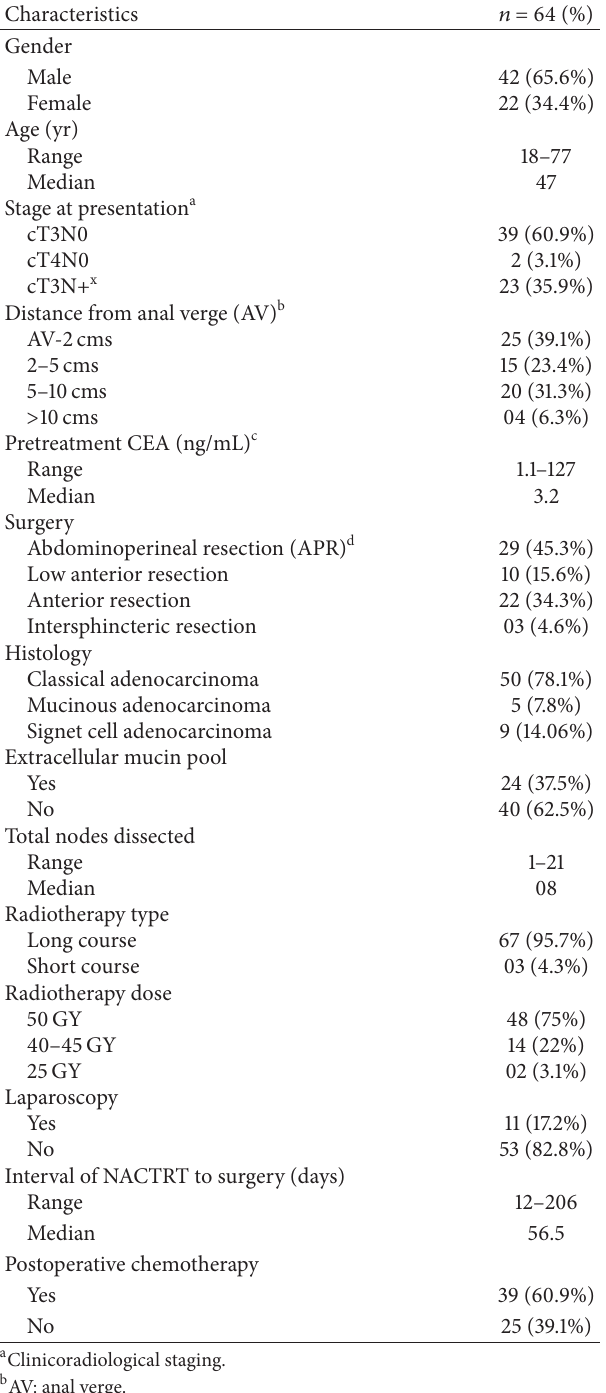
Table 1: Demographic and clinicopathological